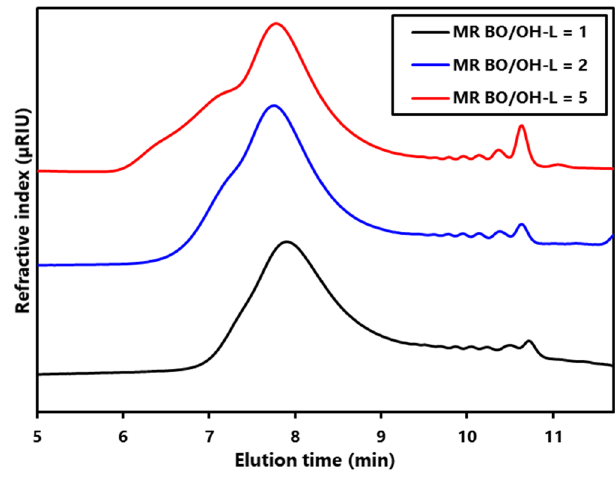
Figure 1. Influence of the BO/OH-OL molar ratio on the LBPs M w